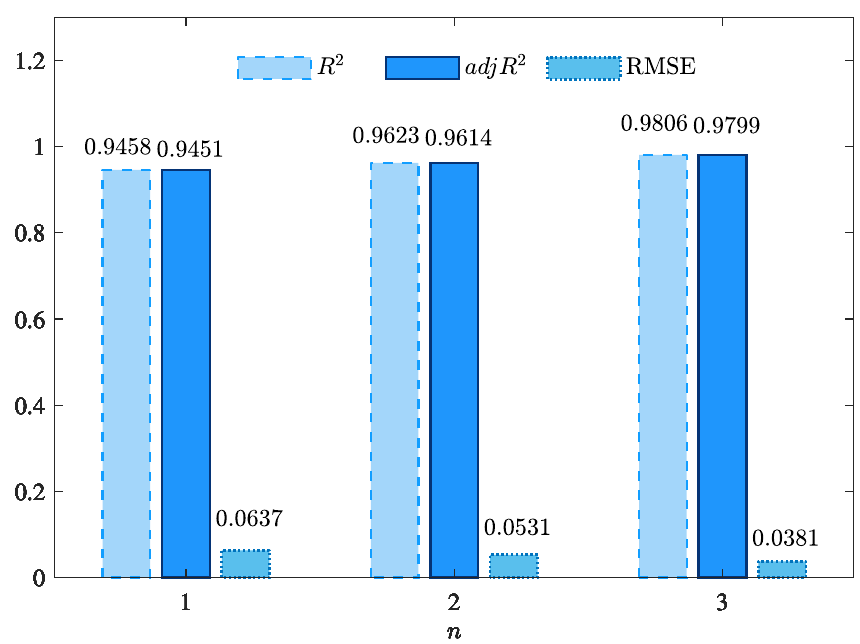
Figure 4. The values of R 2 , adjR 2 , and RMSEs given by the MLFF-PE algorithm for different orders n .